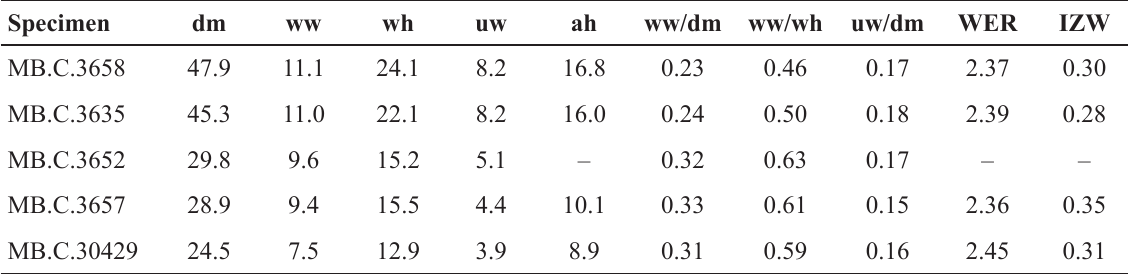
Table 5. Conch dimensions and ratios of selected specimens of Darkaoceras galeatum (Matern, 1931). Specimen dm ww wh uw ah ww/dm